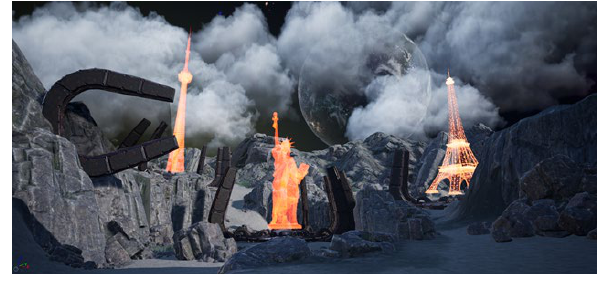
Figure 6. Dystopian